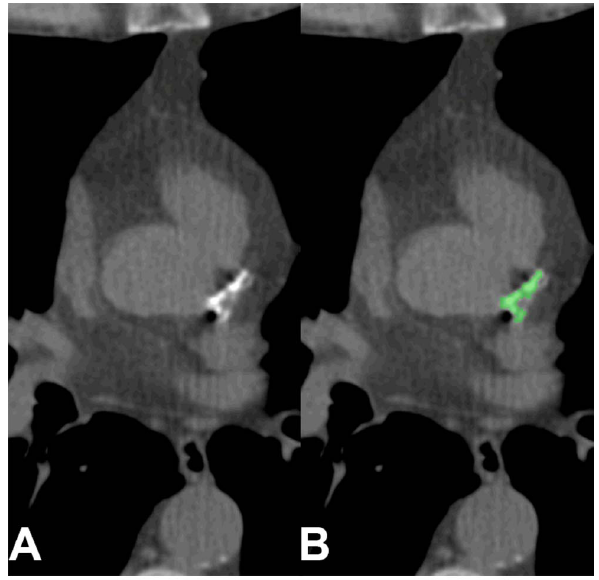
Figure 1. False negative by automated scoring. Example of missed calcification in the LM by automated scoring method (A) compared with reference calcification in green (B). No stent was